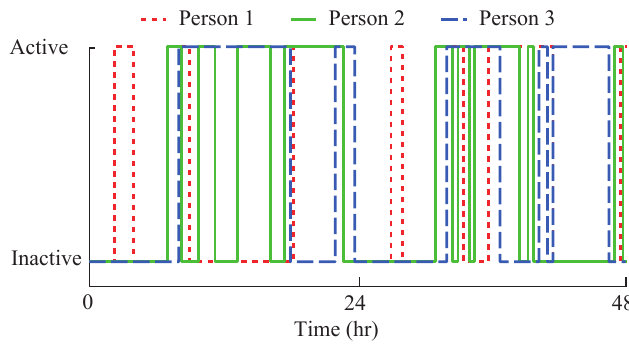
Figure 2. Occupancy profile of three occupants from different households in two days with a 15-min time interval. Active: the occupant is at home and